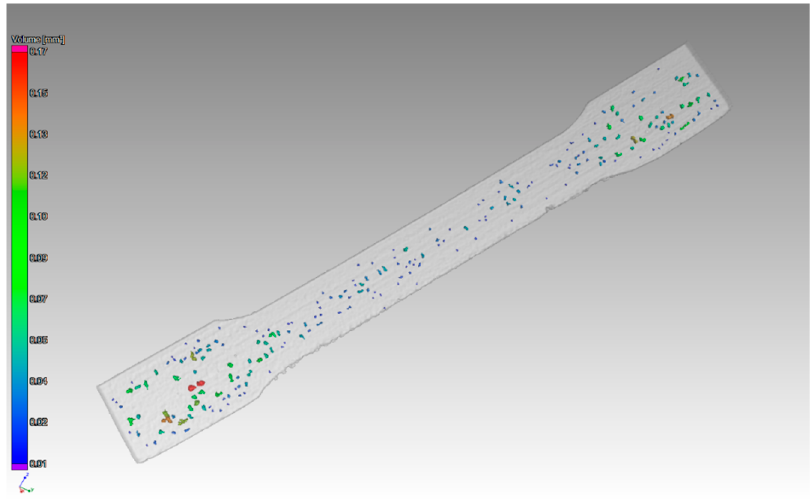
Figure 8. Defects detected in the sample with thickness of 1 mm printed in XZ directions. The identification of the biggest defects at specific locations of the sample with 1 mm thickness, which was oriented in the XZ direction, is shown in Figure 9.